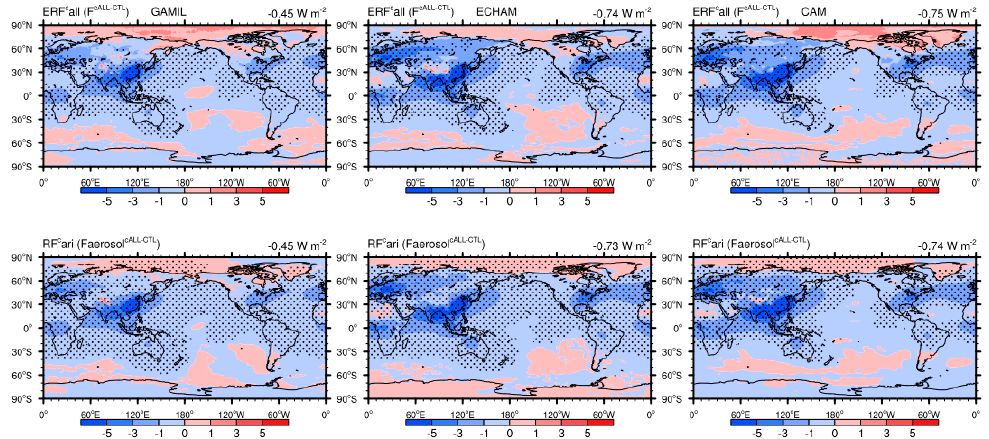
Figure 3. Same as Figure 2, but for clear-sky effective radiative forcing (ERF c all = F cALL − CTL , upper panel) and clear-sky instantaneous radiative forcing from aerosol–radiation interactions (RF c ari = Faerosol cALL − CTL , lower panel).